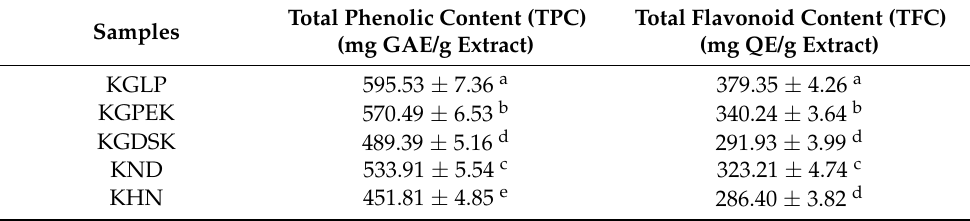
Table 2. Total phenolic and flavonoid contents of purple rice extracts.